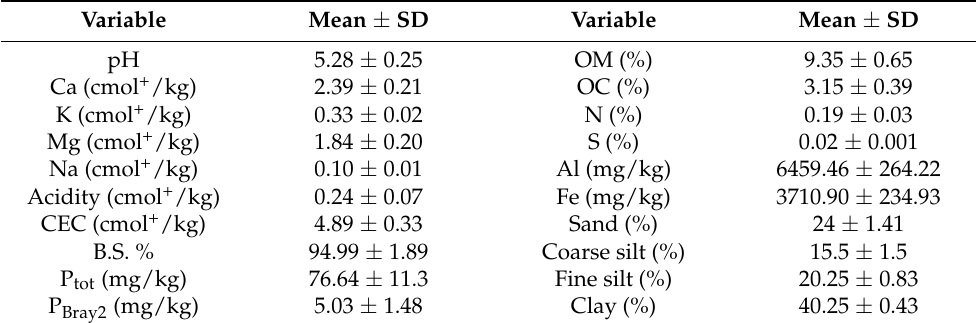
Table 1. Soil properties of the Mikembo site, 20 cm depth.